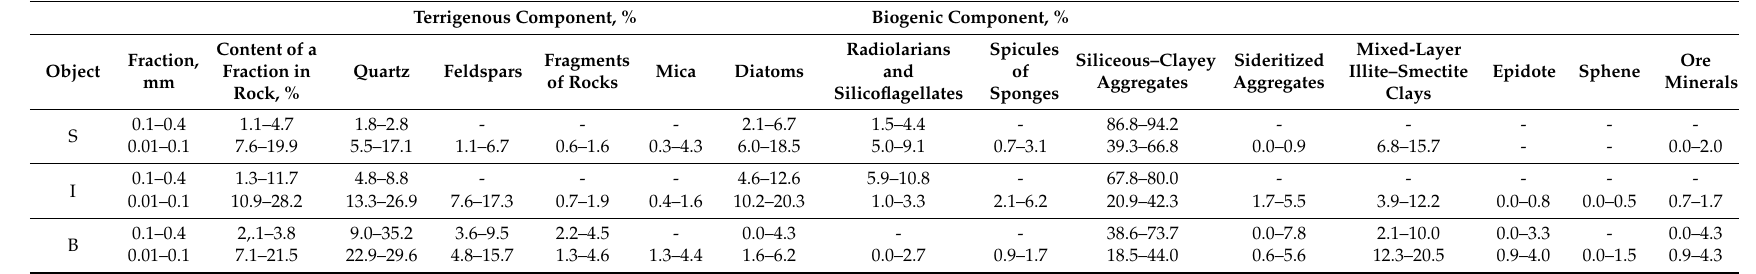
Table 2. The mineral composition of fractions of 0.1–0.4 and 0.01–0.01 mm, extracted from samples of diatomites and diatomaceous